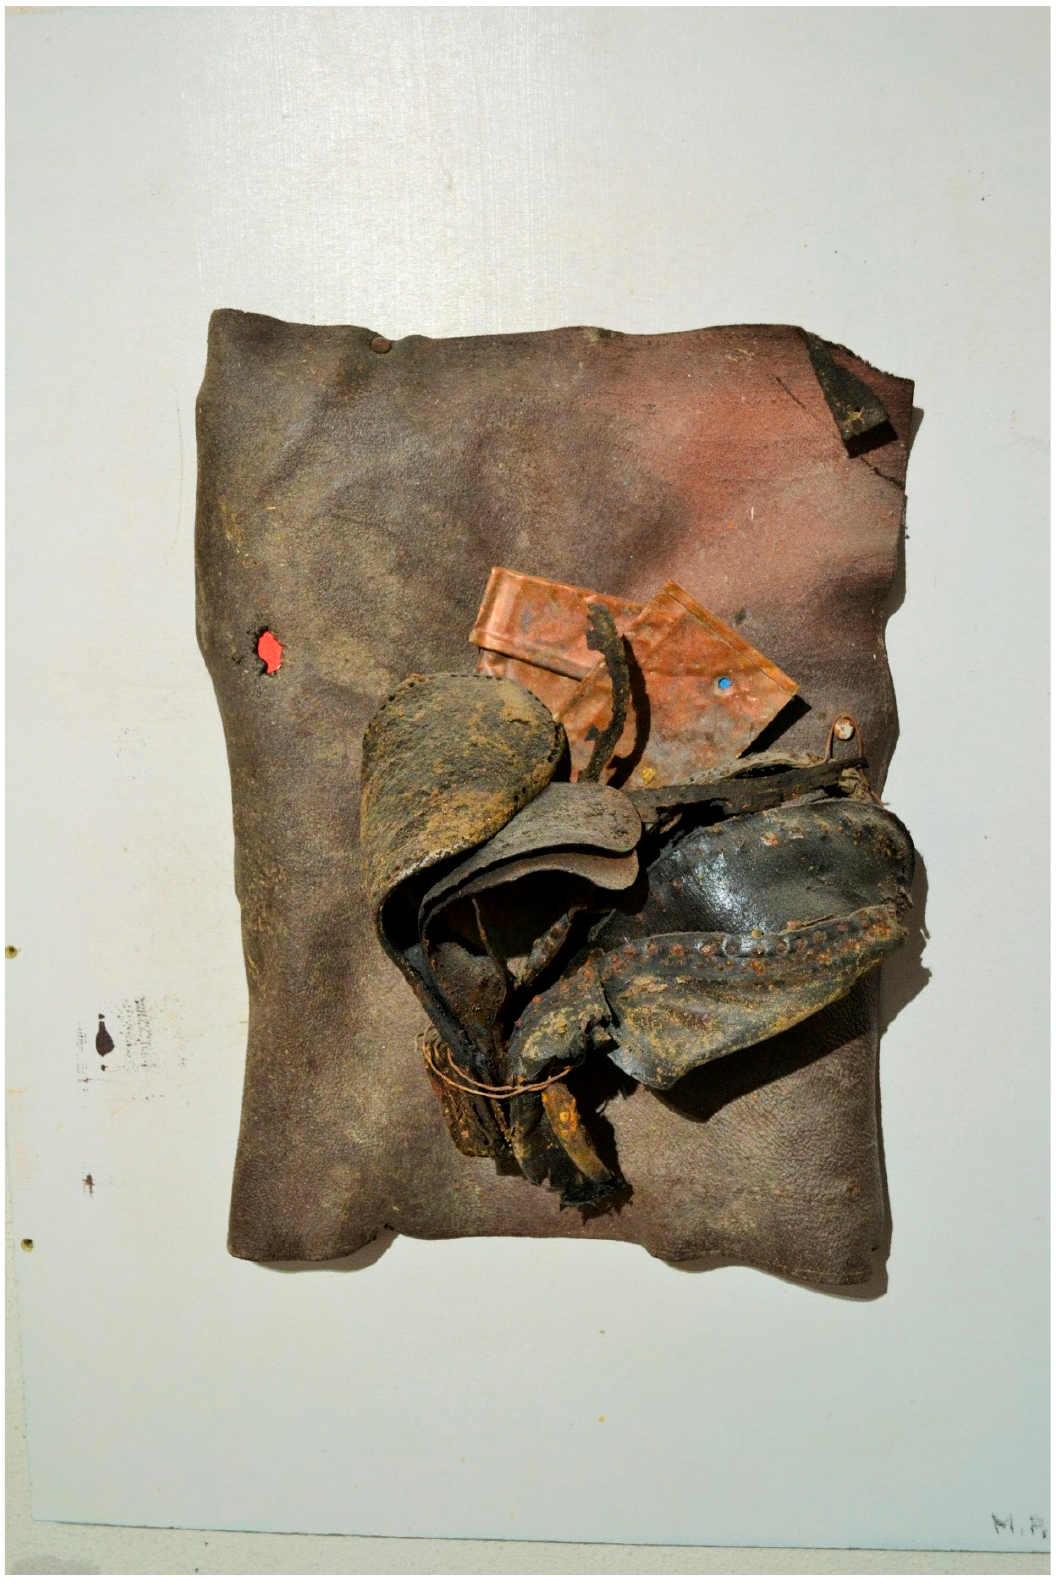
Figure 5. Another Man’s Shoe. Photo by Agricubismo ® .